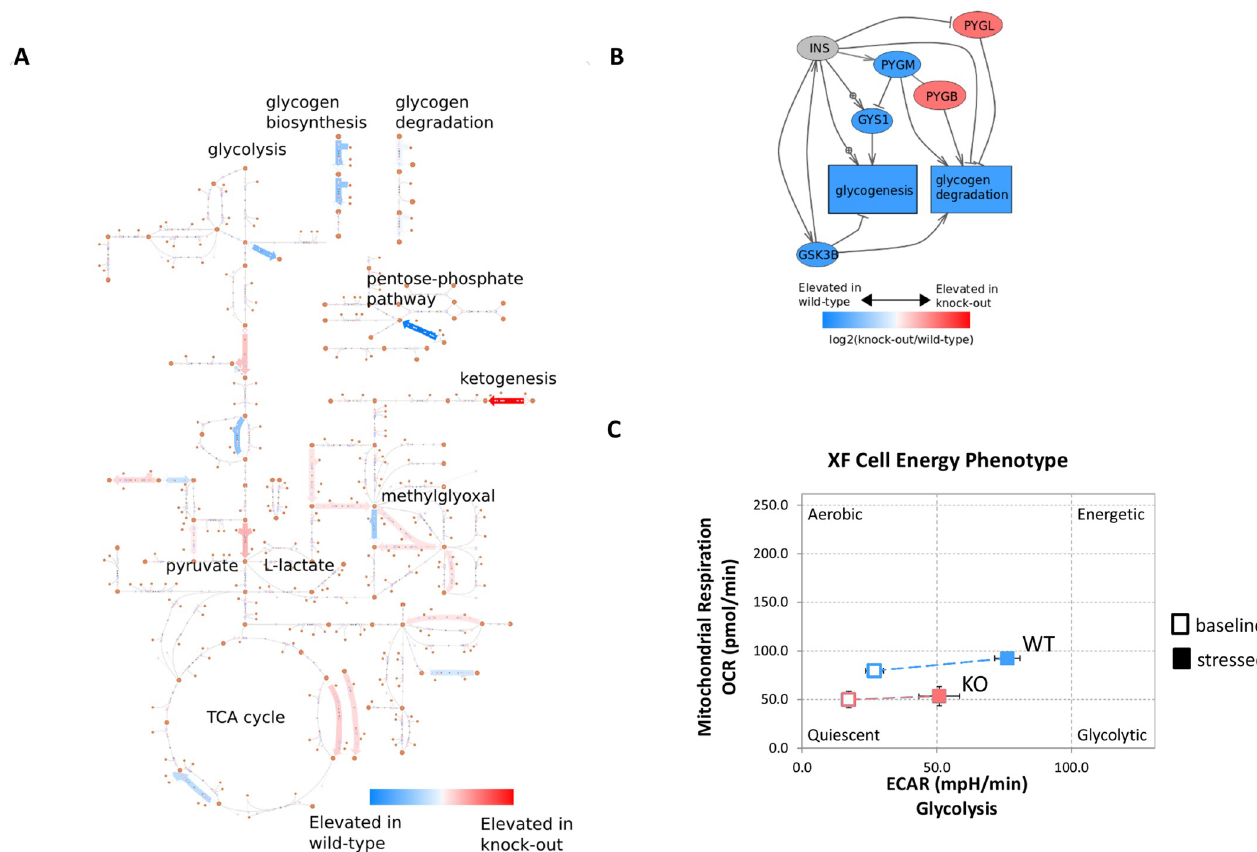
Fig 5. A. Map of metabolic pathway perturbations in HCT116-GSK3 β -KO cells. All significantly differentially expressed proteins were mapped using the Escher tool for metabolic pathway mapping. B. Glycogen metabolism proteins significantly altered in HCT116-GSK3 β -KO cells. Glycogen metabolism protein sub-network. All red or blue colored proteins were significantly (p < 0.05) differentially expressed in wild-type (blue) or knockout cells (red). C. Metabolism phenotype assay of HCT116-GSK3 β -WT and HCT116-GSK3 β -KO cells. Cell metabolism assessed by Agilent Seahorse XFp cell energy phenotype test, oxygen consumption rate (OCR) and extracellular acidification rate (ECAR) were used as measures of mitochondrial respiration and glycolysis respectively, under basal and stressed conditions to assess metabolic potential of cells. N = 3.